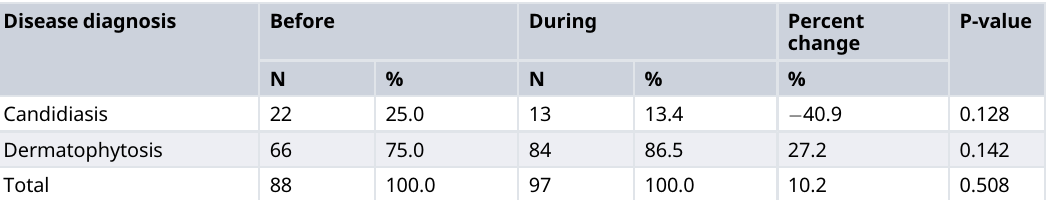
Table 4. The types of cutaneous fungal infection before and during the coronavirus disease 2019 (COVID-19) pandemic. Disease diagnosis Before During Percent